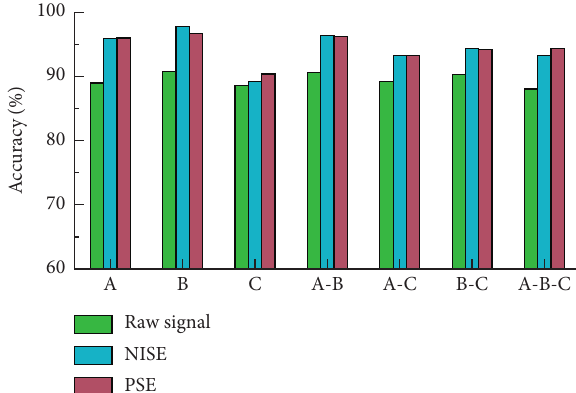
Figure 16: Performance of CNN based on different approaches on three volunteers and their fusion data in an empty